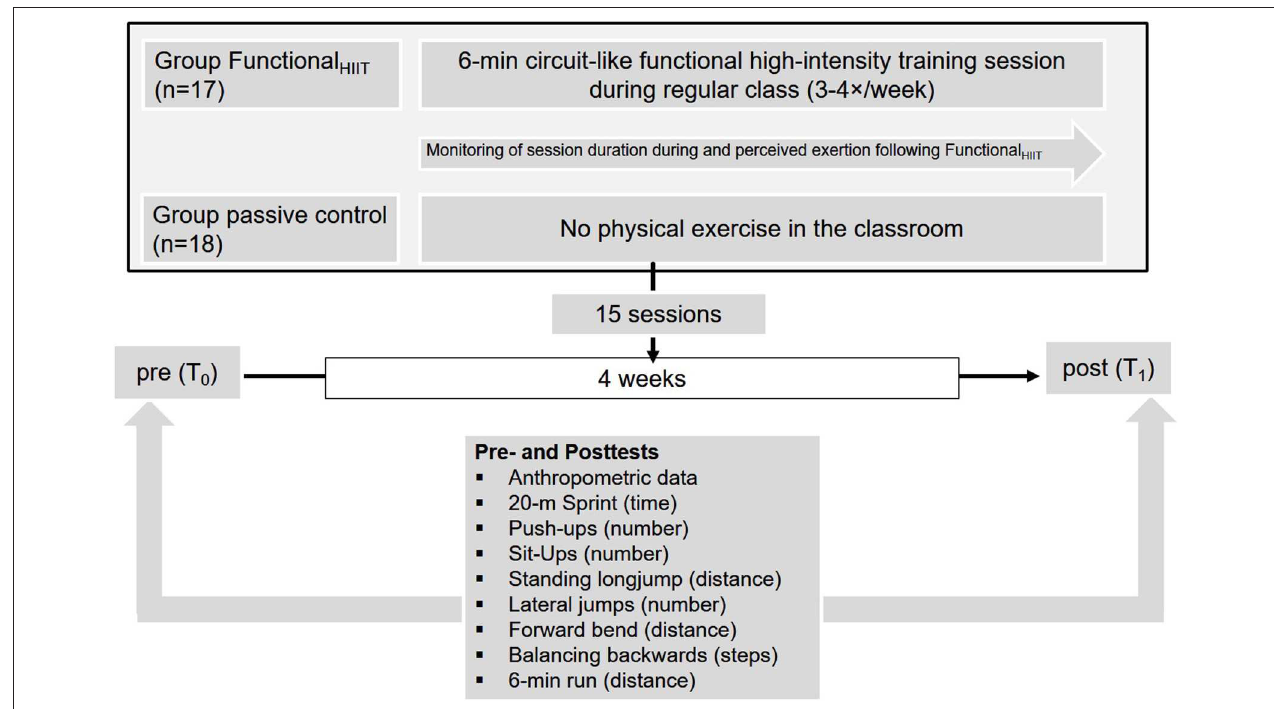
FIGURE 1 | The study design, including testing prior to (T 0 ) and following the intervention period (T 1 ).